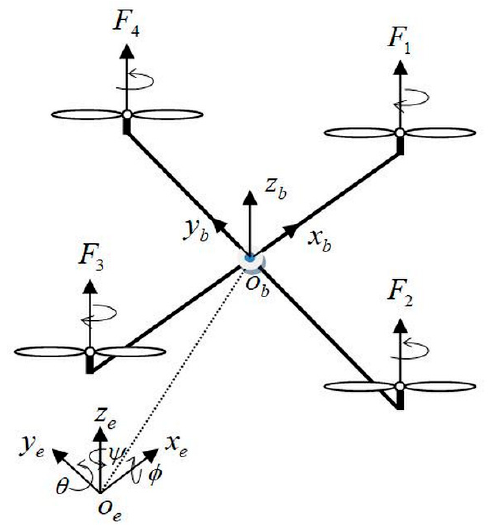
respectively, the roll, the pitch, and the yaw angles, such that − π − π < ψ < π .